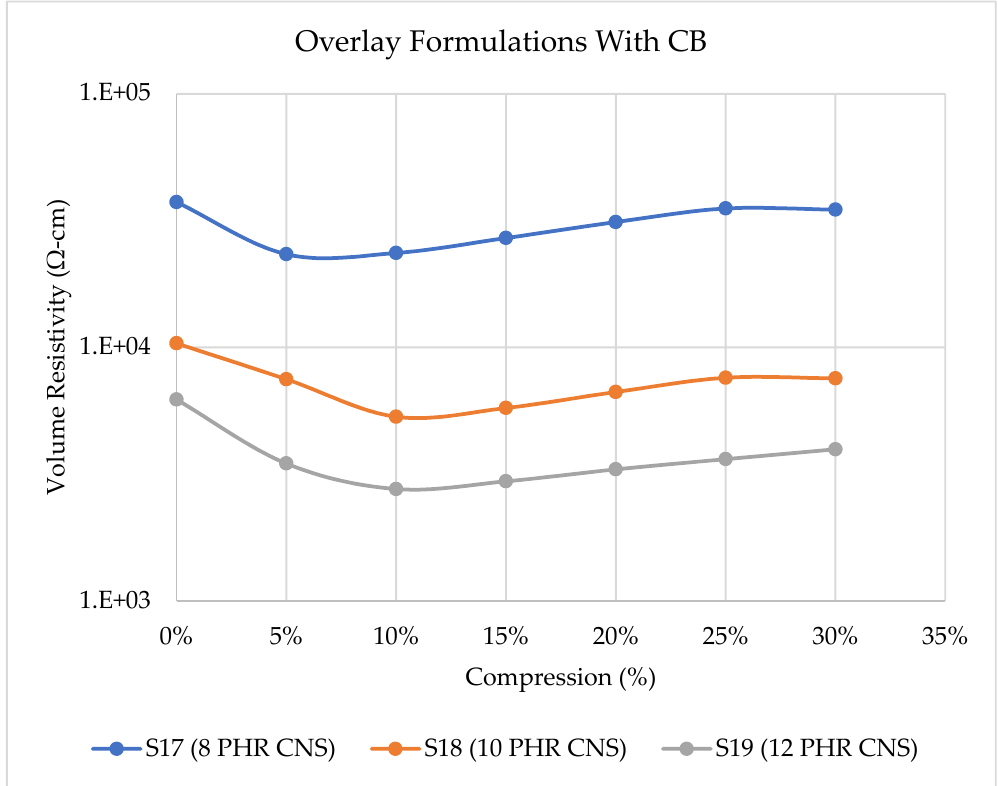
Figure 5. Effect of CNS content within FFKM elastomer O-ring formulations on volume resistivity across multiple compression levels.